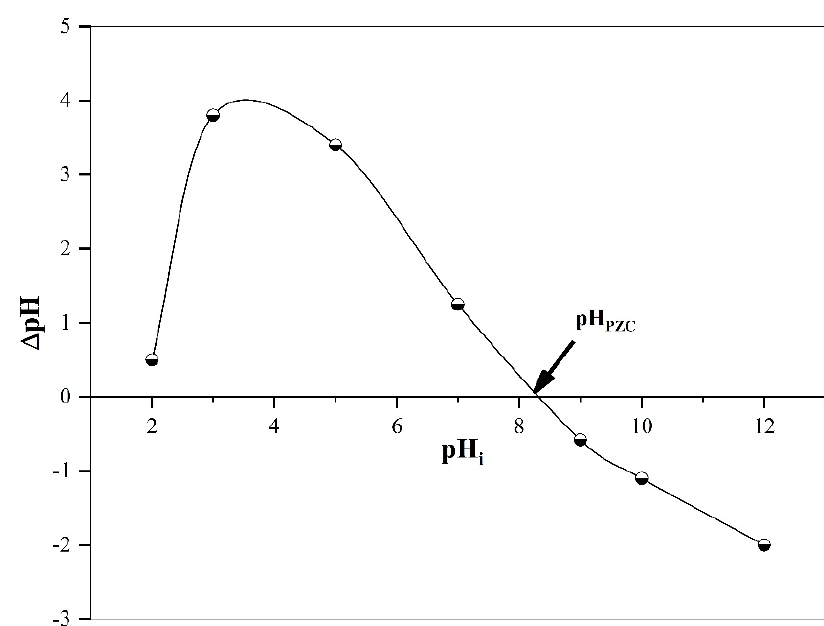
Figure 4. Point zero charge for ACSCGs.